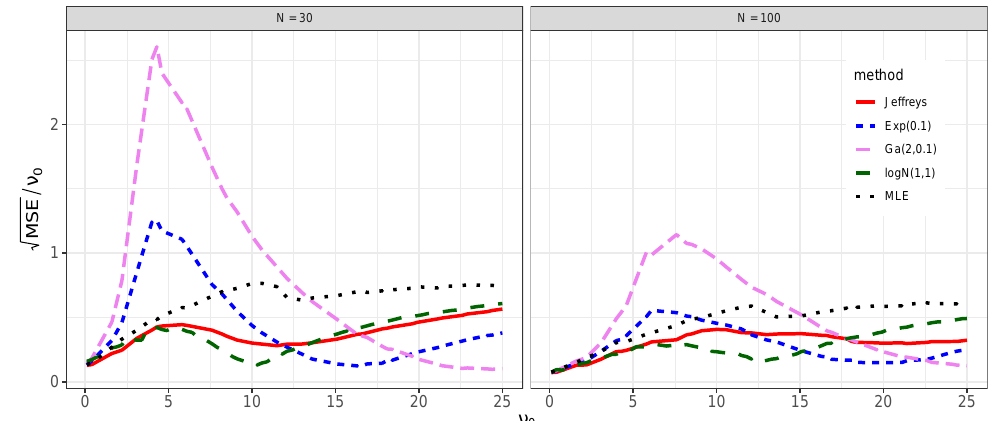
Figure 5. Frequentist properties of the posterior mean based on the four priors ( π J ( ν ) (4), π E ( ν ) (5), π G ( ν ) (6), and π L ( ν ) (7)) and MLE of ν , for sample sizes N = 30 and N =